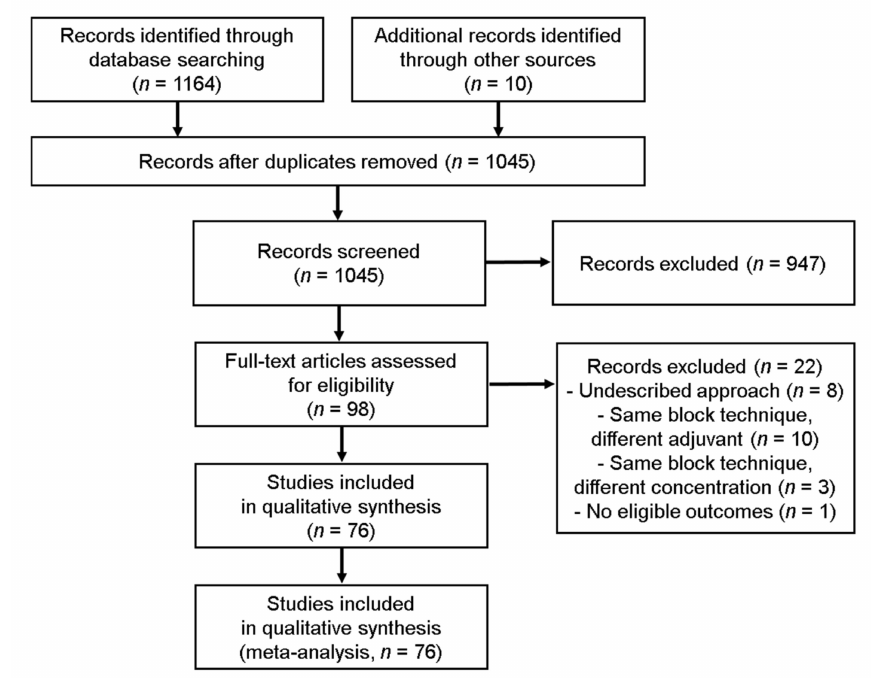
Figure 1. PRISMA flow diagram of literature search and selection.